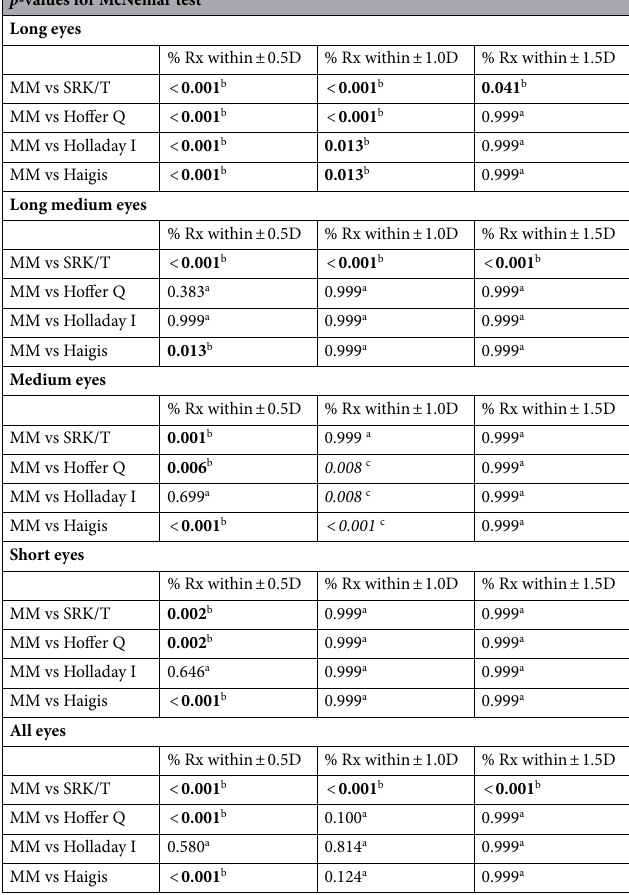
Table 10. Pairwise comparison of the prediction accuracy (i.e., the percentage of eyes within a given range of prediction error) between the MM formula and each of the other four formulae (SRK/T, Hoffer Q, Holladay I and Haigis) for the different types of eyes (long, long medium, medium, short and all eyes), using the McNemar test at a statistical significance level of 5%. a No statistically significant difference at level 0.05. b MM formula outperformed at significance level 0.05. c MM formula underperformed at significance level 0.05. Significant values are in [bold,